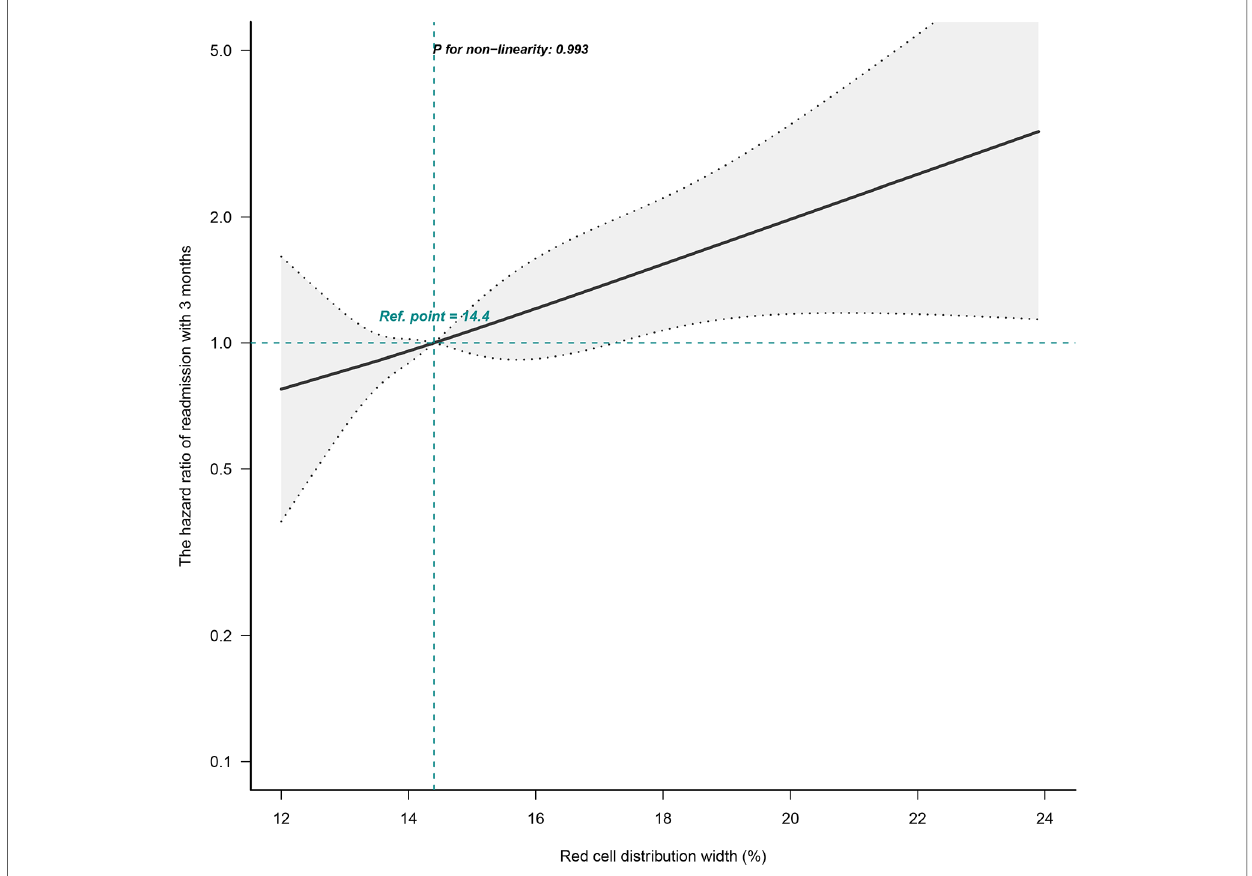
FIGURE 1 Dose-response relationships between RDW and the hazard ratio of readmission within 3 months. The black solid line represents the estimated risk of readmission within 3 months, with dashed lines showing 95% con fi dence intervals. The blue histogram at the bottom represents the distribution of RDW. Analyses were adjusted for age, sex, BMI, CCI score, NYHA cardiac function classi fi cation, type of heart failure, BNP, RBC, HB, total protein, ALB, ALT, LDH, and eGFR. RDW, red cell distribution width; BMI, body mass index; CCI, charlson comorbidity index; NYHA, new york heart association; BNP, brain natriuretic peptide; RBC, red blood cell, HB, hemoglobin; ALB, albumin; ALT, alanine aminotransferase; LDH, lactate dehydrogenase; eGFR, estimated glomerular fi ltration